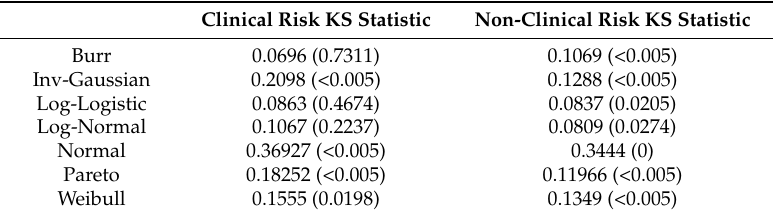
Table 6. Kolmogorov-Smirnov test of severity distribution.